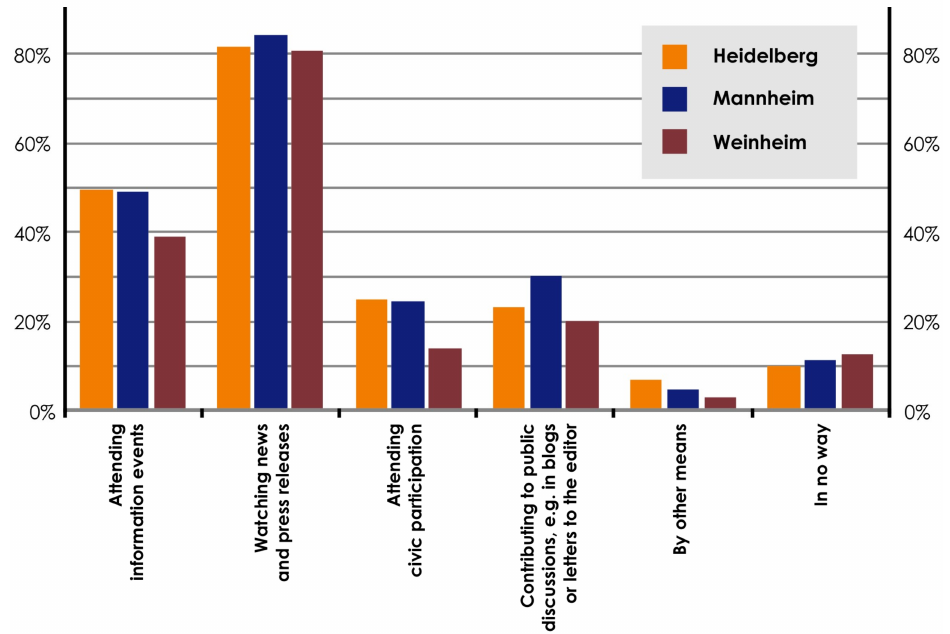
Figure 3. If you were to learn of specific plans for this area, in what form could you imagine accompanying the planning process? Own illustration, based on household surveys, Heidelberg (n = 128), Mannheim (n = 127), and Weinheim (n =